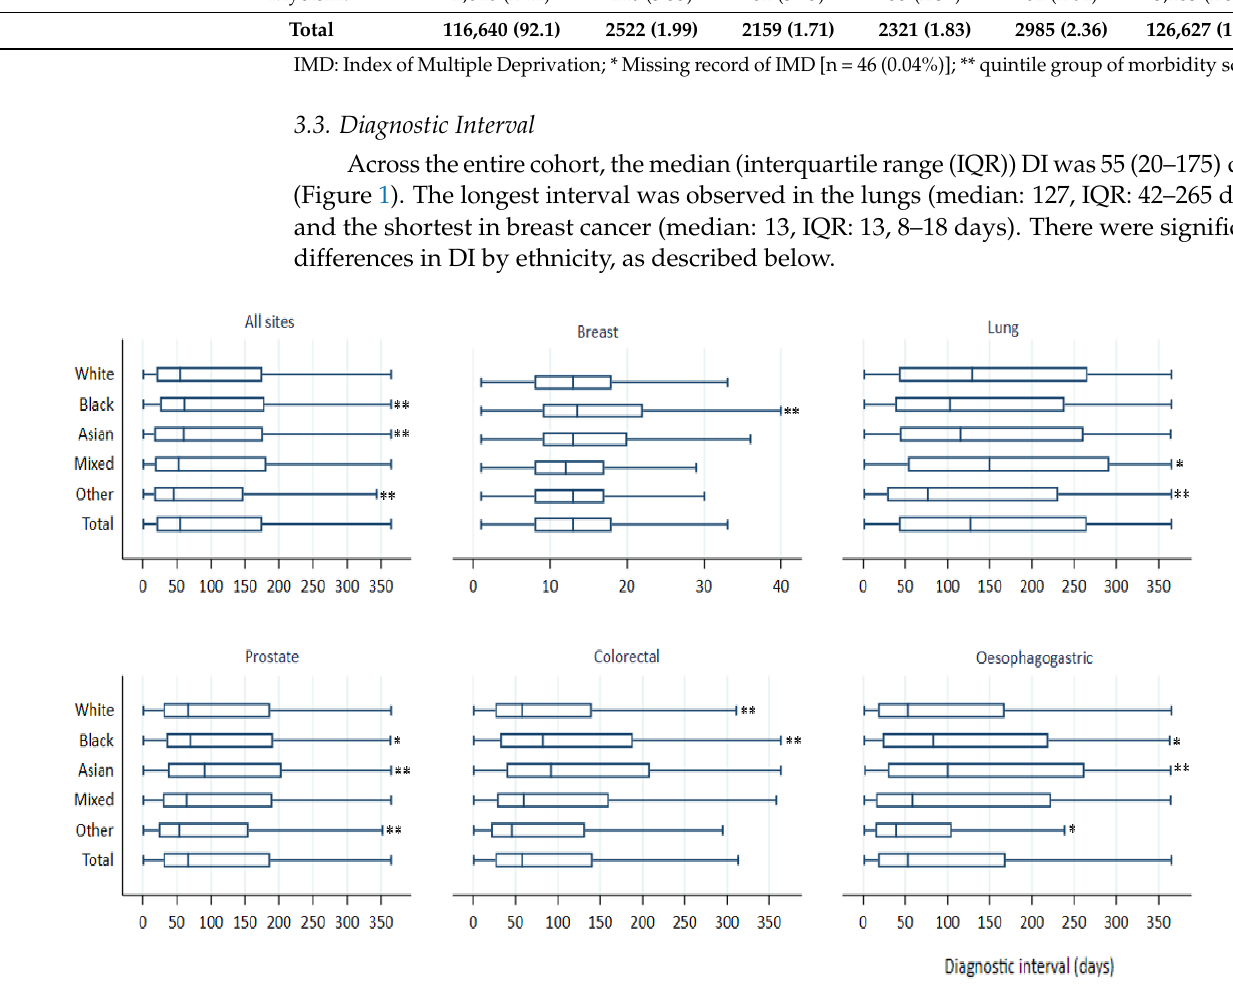
Figure 1. Site-specific box and Whisker plots showing ethnic differences in the number of days to diagnosis (lower adjacent value, 25th, 50th, and 75th centiles, and upper adjacent value). Figures are the exact number of days from index feature to diagnosis. Asterisks indicate significant ethnic dif- ferences in DI compared with the White group: (** p -value ranges from 0.001 to 0.004) (* p -value ranges from 0.01 to 0.05). 3.4. Ethnic Differences in Diagnostic Interval Across all sites, the median (IQR) DI was 55 (20–175) days in the White group, 61 (25– 179) days in Black, 60 (17–176) days in Asian, 53 (18–182) days in the Mixed, and 45 (17– 148) days in the Other ethnic group (Figure 1). After adjusting for age, sex, IMD, and mor- bidity score, DI for the Black and Asian groups was 10% (adjusted AFT ratio, 95%CI: 1.10, 1.05–1.14) and 16% (1.16, 1.10–1.22) longer, and 12% (0.88, 0.84–0.91) shorter in the Other group than for the White group. DI was similar between the Mixed and the White group (Table 3). There was strong evidence of interaction between site and age, IMD, and mor- bidity score ( p < 0.001 for each of these), and between cancer site and sex ( p = 0.04). The effect of sex was such that women were diagnosed somewhat faster than men in cancers affecting both sexes, with the largest difference for oesophagogastric cancer (AFT ratio = 1.17) and the smallest difference for lung and colorectal cancer (AFT ratio =1.10 for both). Importantly, we found evidence of interaction between site and ethnicity ( p < 0.001), sug- gesting that the effect of ethnicity on DI differs by cancer site. Table 3 shows the main